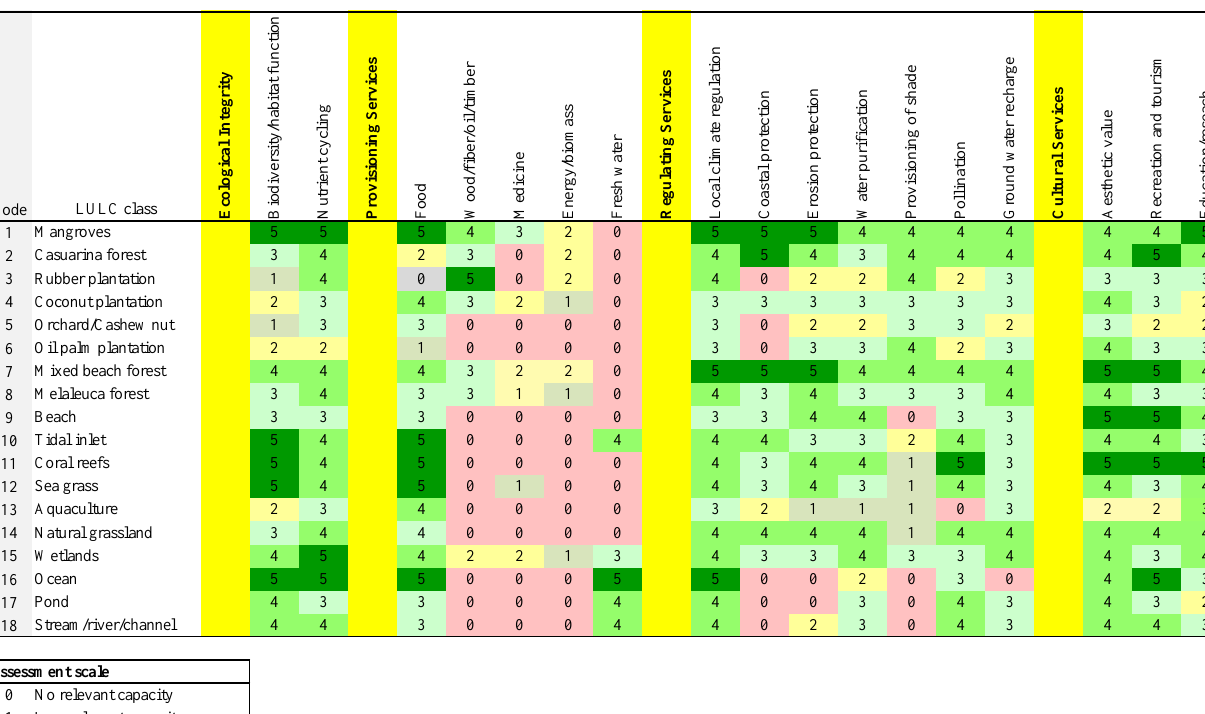
Table 1: Ecosystem services matrix for the coastal areas of the Phang Nga province, Thailand linking LULC classes to their capacities to support ecosystem functions and to supply ecosystem services on the scale: 0 = no relevant capacity, 1 = low